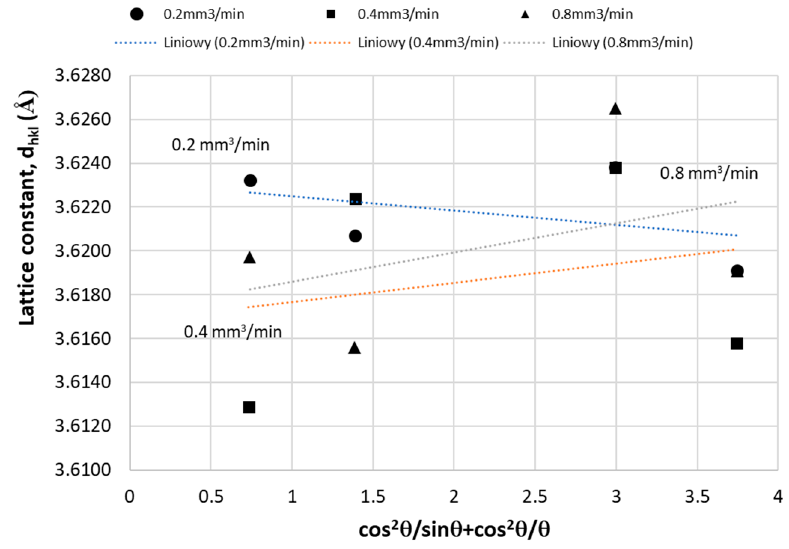
Figure 13. Variation of the lattice parameters of Cu ( α Cu) as a function of the Nelson–Riley (N-R) parameter [16]; for analysis, the four strongest XRD picks from Figures 10–12 were used.